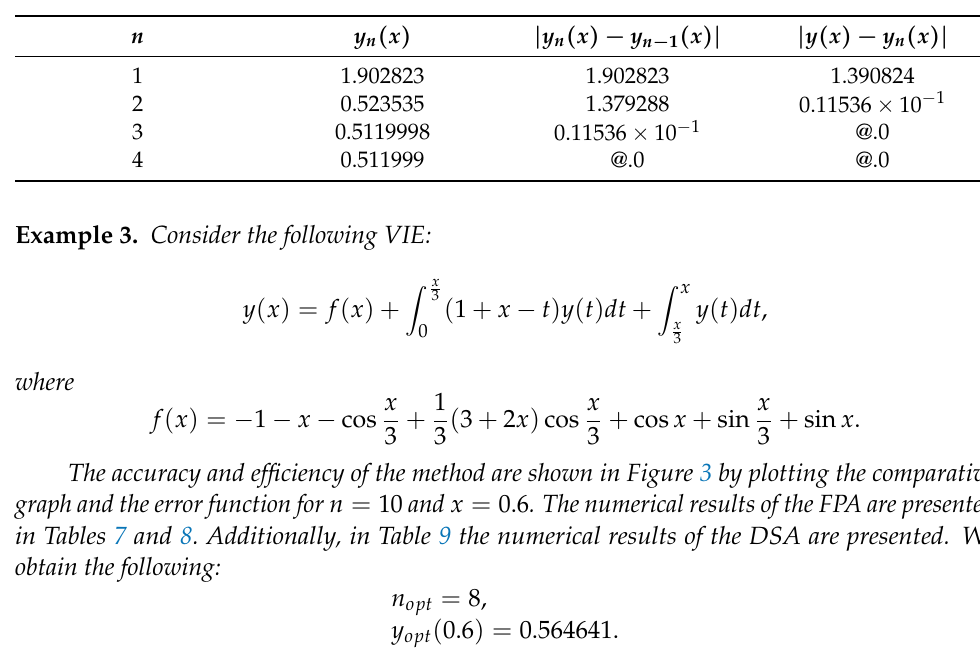
Table 6. Results of the CESTAC method for Example 2 and x =